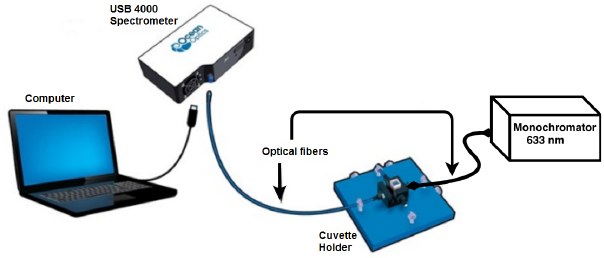
Fig. 3. Transmission-based experimental setup for spectro- scopic measurements as the results shown in Table 1. (Cuvette thickness is 0.5